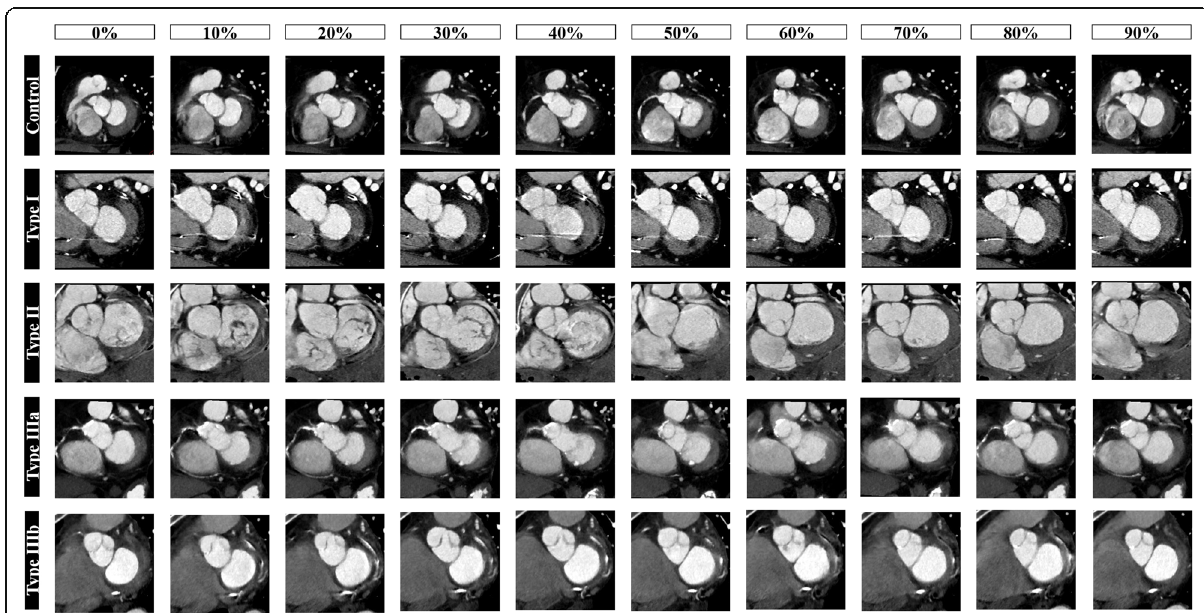
Fig. 5 Short-axis reformatted cardiac computed tomography angiography images of the mitral valve annulus in each cardiac phase in exemplifying control patient and in mitral regurgitation patients according to Carpentier classification